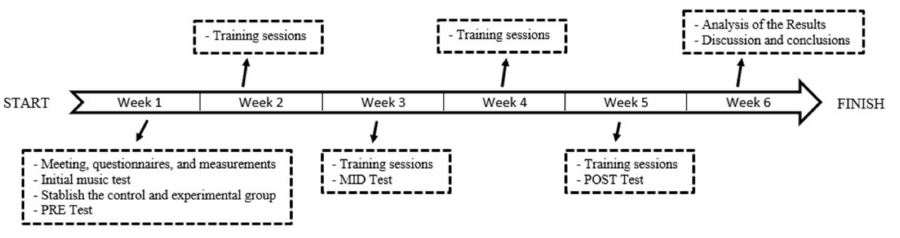
Figure 1. Research’s